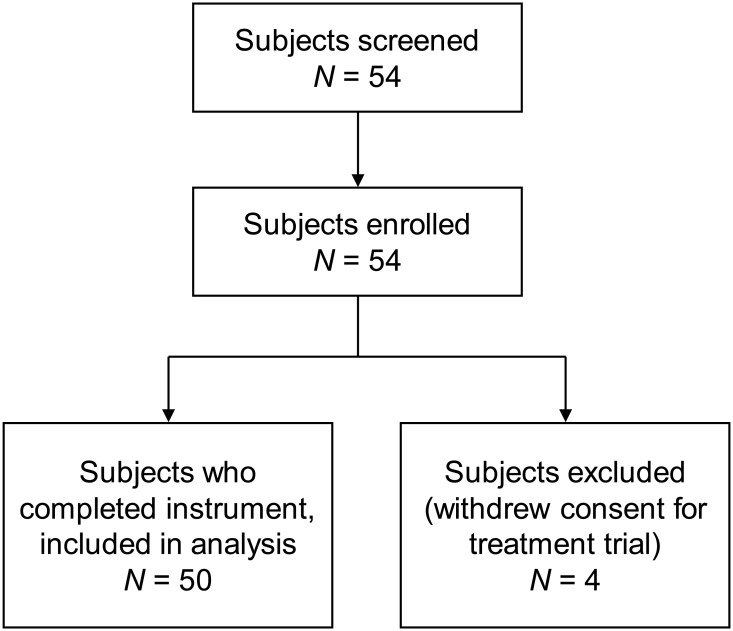
CONSORT diagram for flow of study participants.